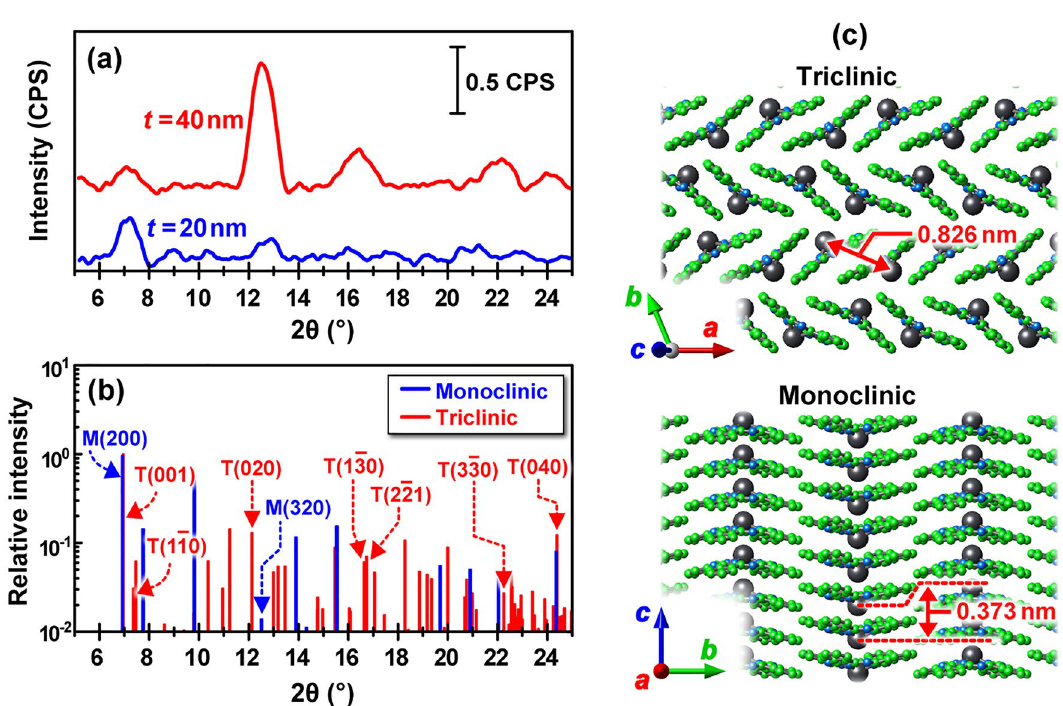
Figure 2. ( a ) XRD patterns of the 20 nm (blue) and 40 nm (red) thick PbPc films formed on quartz substrates, ( b ) simulated XRD patterns of the monoclinic (blue) and triclinic (red) crystal phases using an X-ray wavelength of 1.5405 nm (Cu-Kα1) [the maximum peak intensity of both phases was individually normalized to unity], ( c ) schematic illustration of the triclinic (top) and monoclinic (bottom) crystal the monoclinic and triclinic phases between the experimental and theoretical results and behind PbPc acting as a good absorber for NIR-sensitive OSCs.